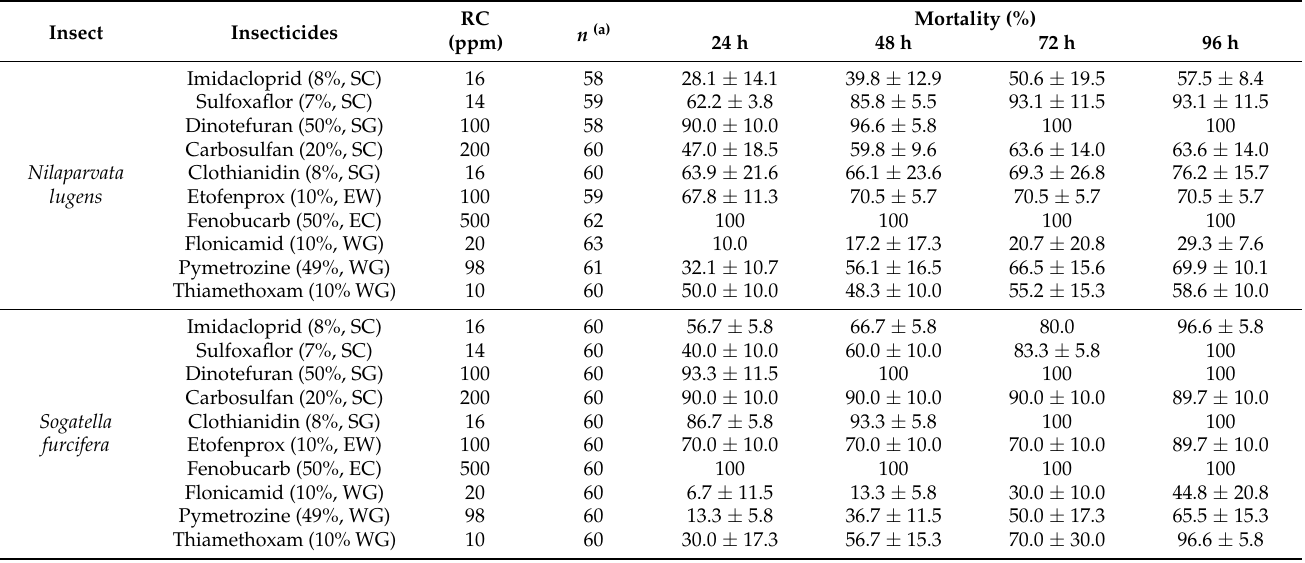
Table 1. Comparison of susceptibility of Nilaparvata lugens and Sogatella furcifera at the recommended concentrations of 10 insecticides.